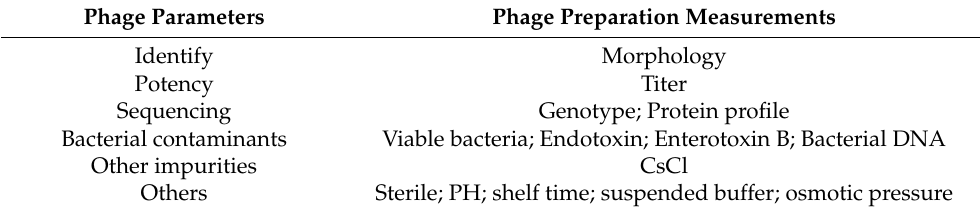
Table 4. Characteristics of phage preparation to be